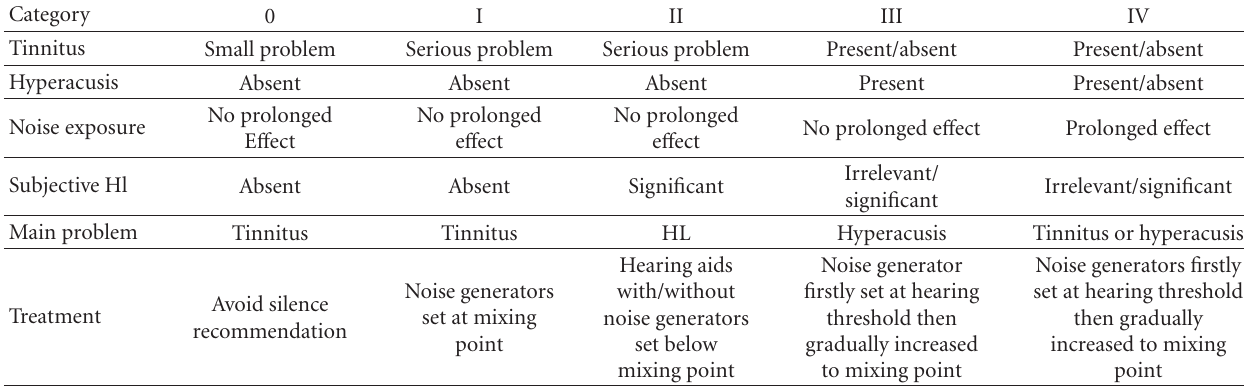
Table 1: Categories of TRT mixing point-level close to the place where the sound from the instrument blends with the tinnitus. Category